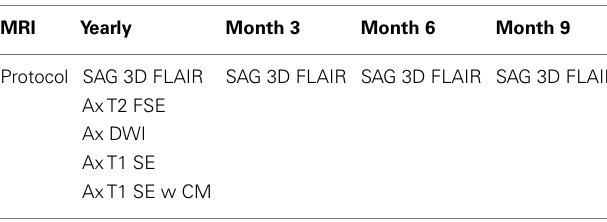
Table 1 | Proposed scanning surveillance with a complete MRI protocol yearly and MRI scans with only 3D FLAIR images with 3months